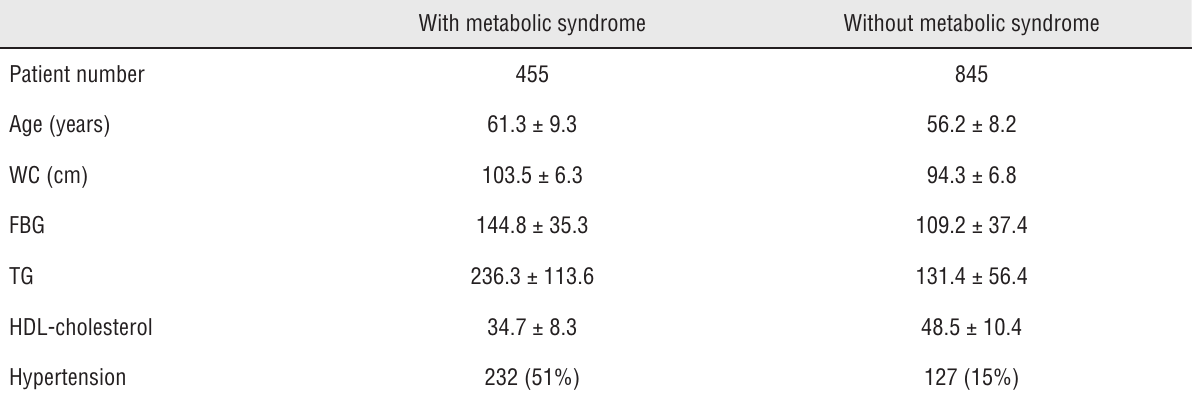
Table 1 - Demographics and laboratory findings of the patients.